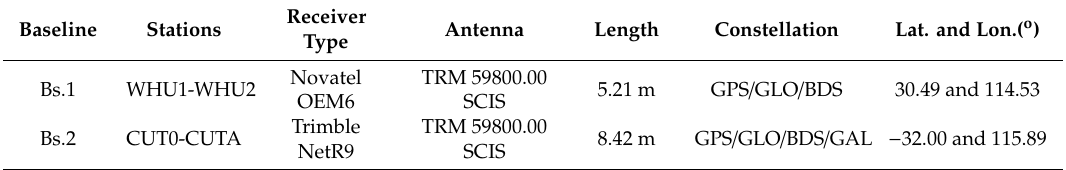
Table 3. General overview of two baselines. Abbreviations: longitude (Lon.) and latitude (Lat.).